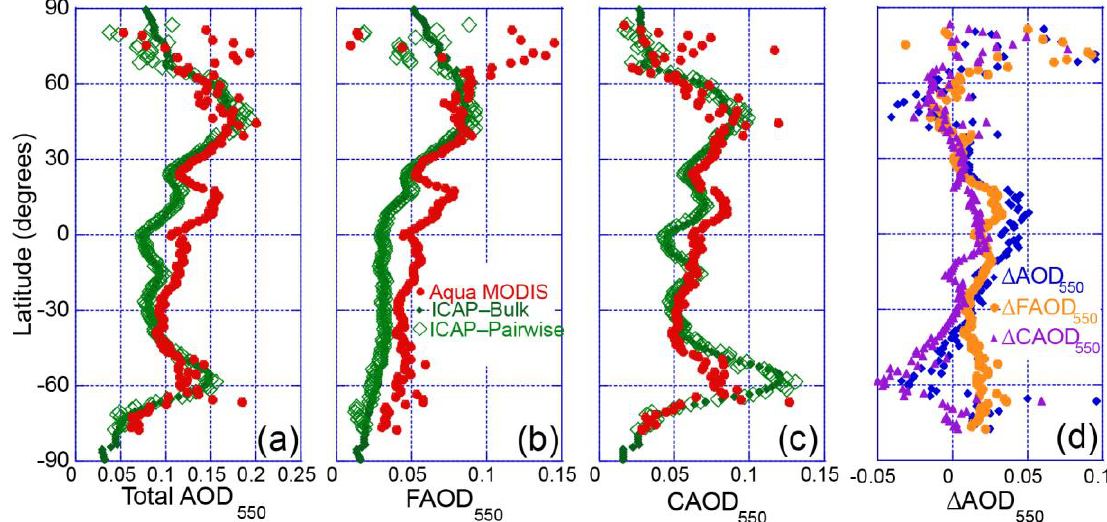
Figure 4. Latitudinal average values AOD components and differences of Aqua MODIS, Bulk ICAP